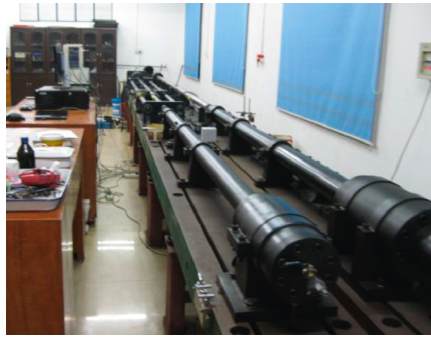
Figure 1: SHPB test apparatus with